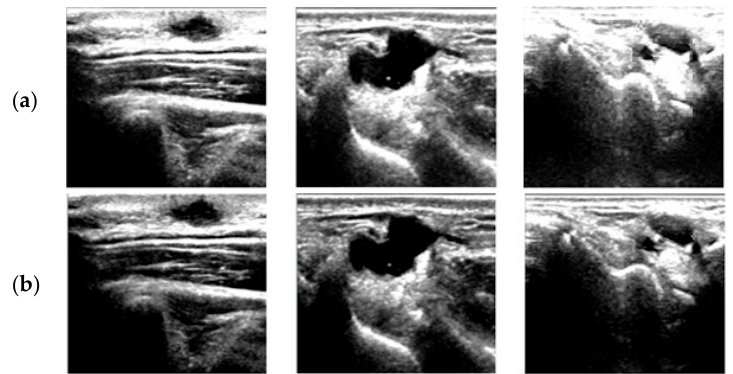
Figure 9. Comparison of fuzzy Stretching. ( a ) Previous [24]. ( b ) proposed.